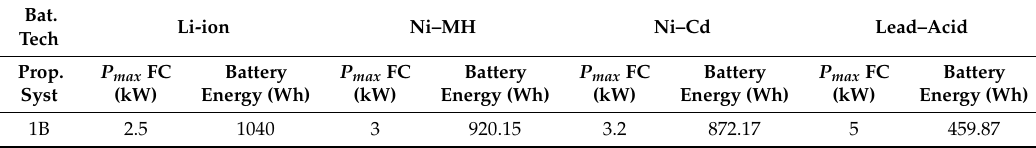
Table 8. Maximum power limit delivered by the fuel cell for the optimal design of the 1B architecture, and energy delivered by the battery using lithium-ion, lead–acid, nickel–metal hydride, and nickel–cadmium